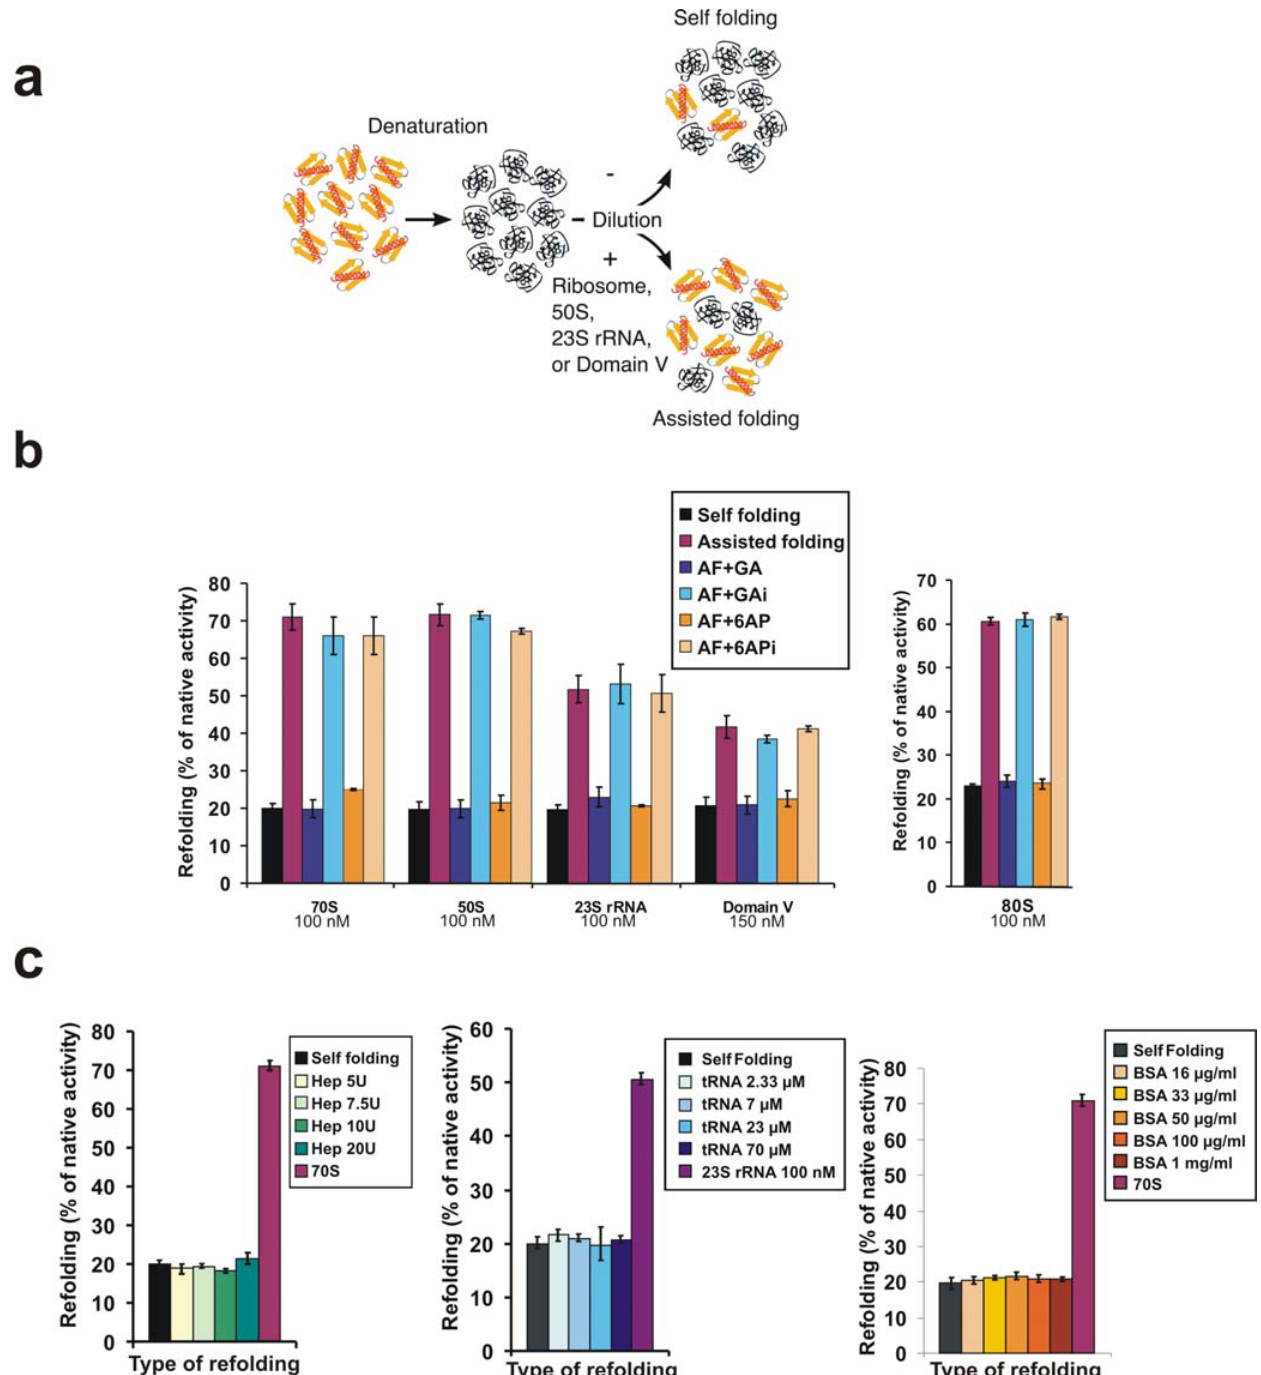
Figure 5. 6AP and GA specifically inhibit the protein folding activity of the ribosome invitro . a. Scheme depicting the principle of the in vitro assay to evaluate the protein folding activity of the ribosome. Human Carbonic Anhydrase (hCA) was denaturated (using GuHCl and EDTA) and then diluted into native buffer to allow refolding. Correct refolding was assessed by measuring the recovery of enzymatic activity as a function of time. Spontaneously, about 20% of the enzyme is able to refold correctly (Self folding, upper part of the scheme). If either a preparation of ribosomes, or the large subunit (50S), or the 23S rRNA, or the domain V of 23S rRNA, are added, the fraction of enzyme able to refold correctly increases up to 70%, due to the protein folding activity of the domain V of 23S rRNA of the large subunit of the ribosome (Assisted Folding -AF-, lower part of the scheme). b. Effect of the various drugs (as indicated) on assisted folding of hCA by eukaryotic (yeast S. cerevisiae , right panel) or prokaryotic ( E. coli left panel) ribosomes (or indicated part of it). Concentration of each folding modulator is indicated. Note that only GA and 6AP, but not GAi and 6APi, were able to inhibit the assisted folding down to the level of self folding. c. Effect of heparin (left panel), tRNA (central panel) or BSA (right panel) on assisted folding of hCA. Note that none of these molecules is able to assist folding of hCA. Negative control is self folding and positive control is the assisted folding by 70S ribosome (for heparin and BSA experiments) or by 23S rRNA (for tRNA experiment).